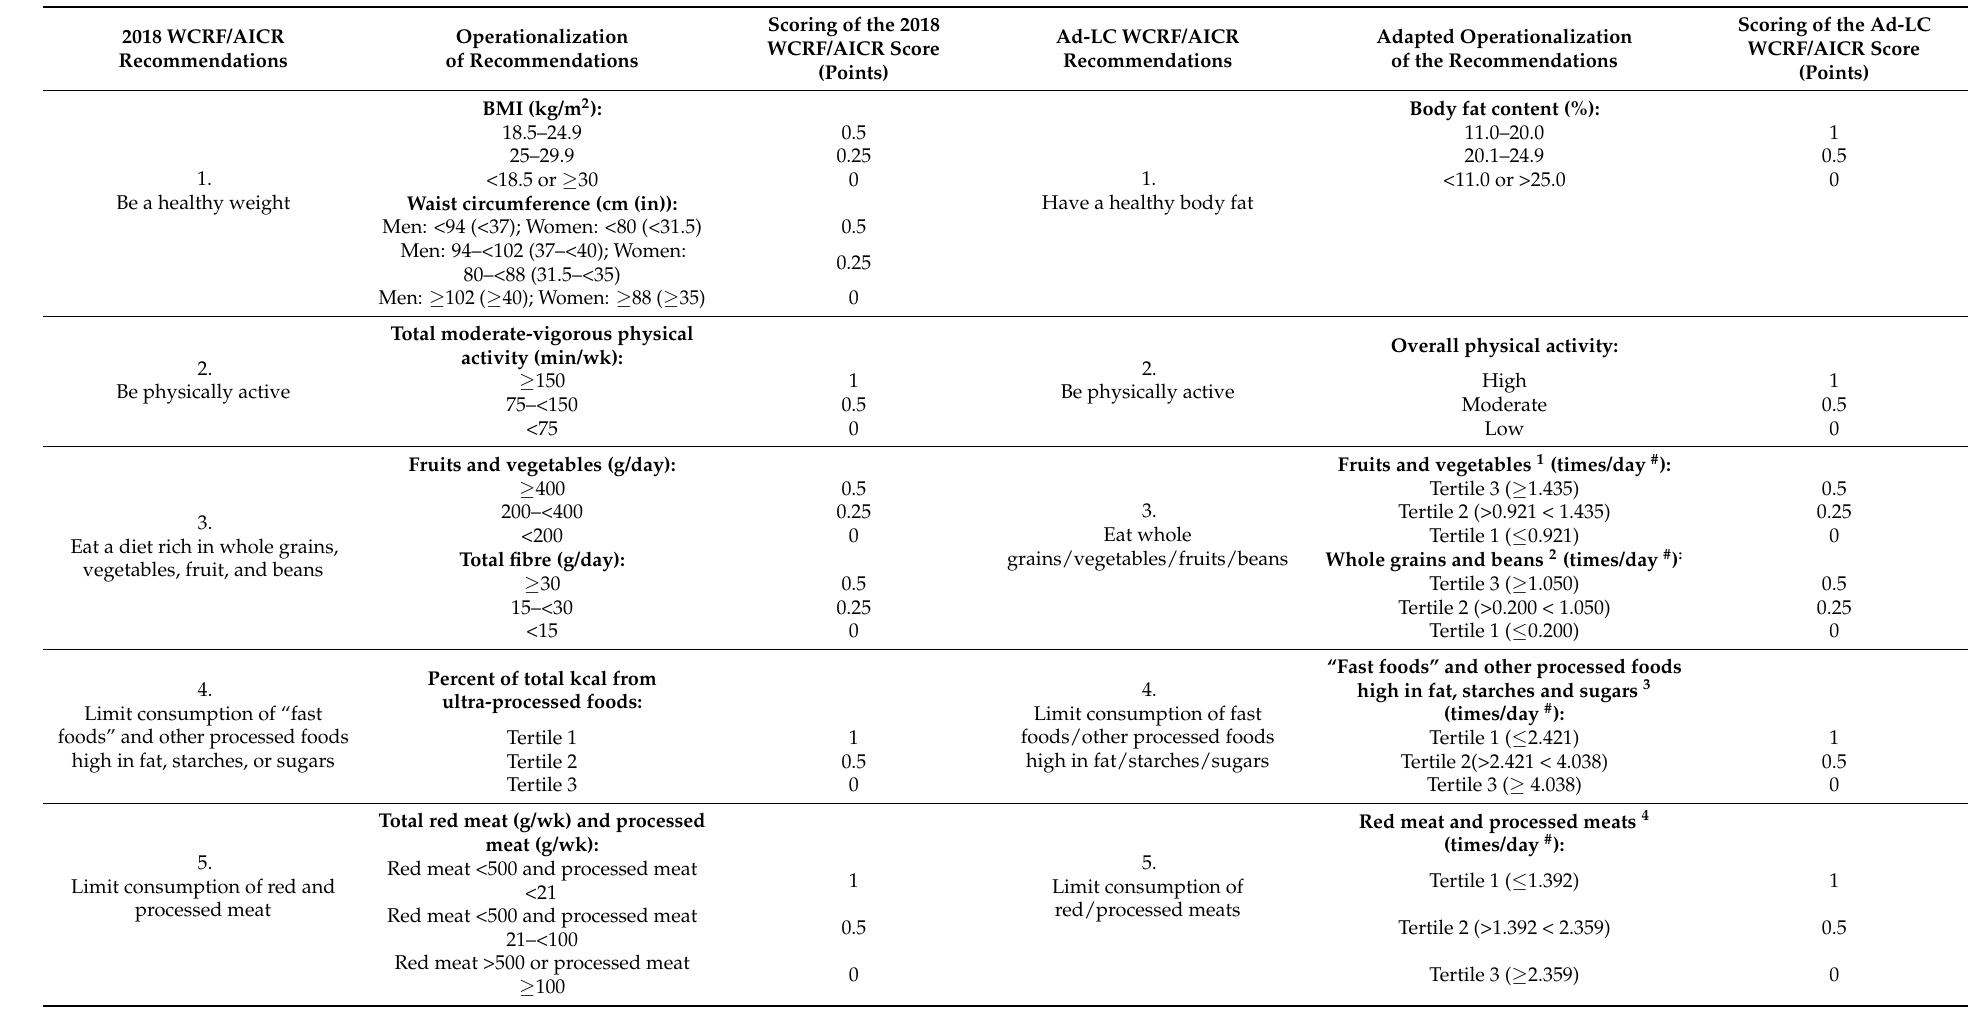
Table 4. Scoring of the official 2018 WCRF/AICR Score and its adapted version with respect to lung cancer (Ad-LC WCRF/AICR